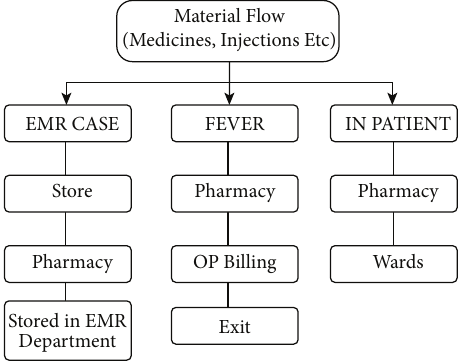
Figure 7. Types of material flow